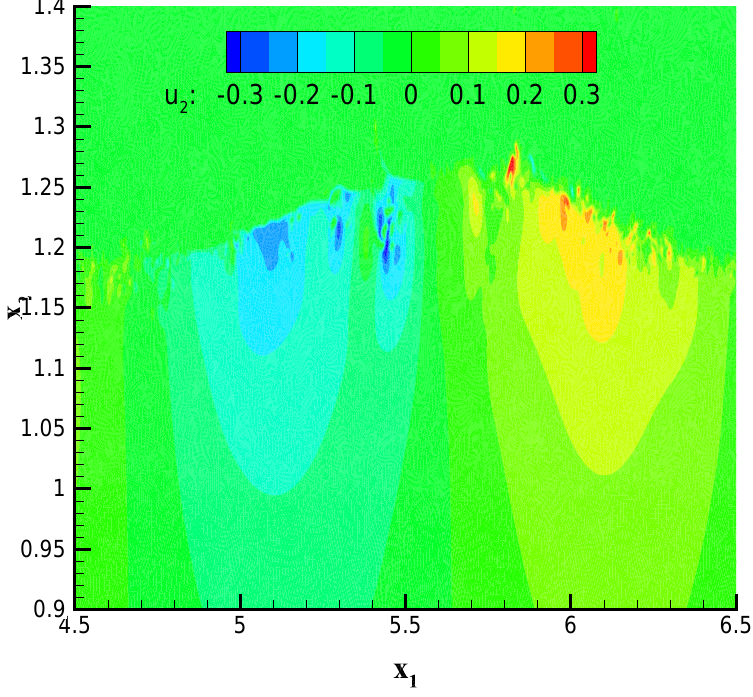
Figure 8. Details of the instantaneous snapshot of wall-normal velocity component (2 [m/s]) at t = 10 [s] for the case with the wind body force f = 0.6 [N/M].